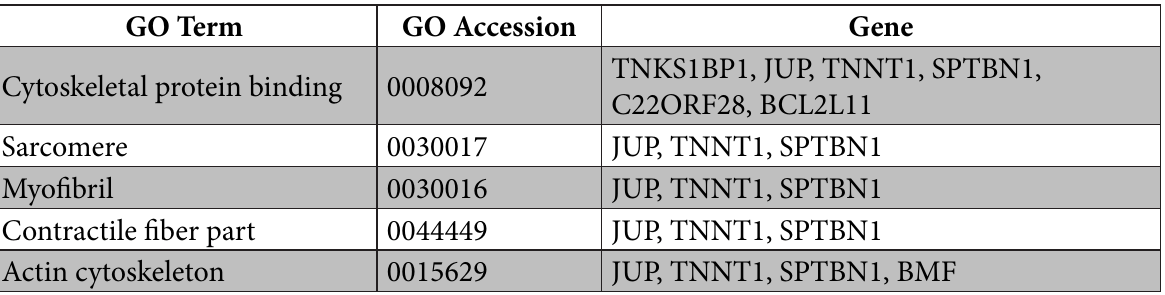
Supplementary Table 2 . Enriched functional annotations of the top 50 differentially expressed genes (DAVID analysis) and included